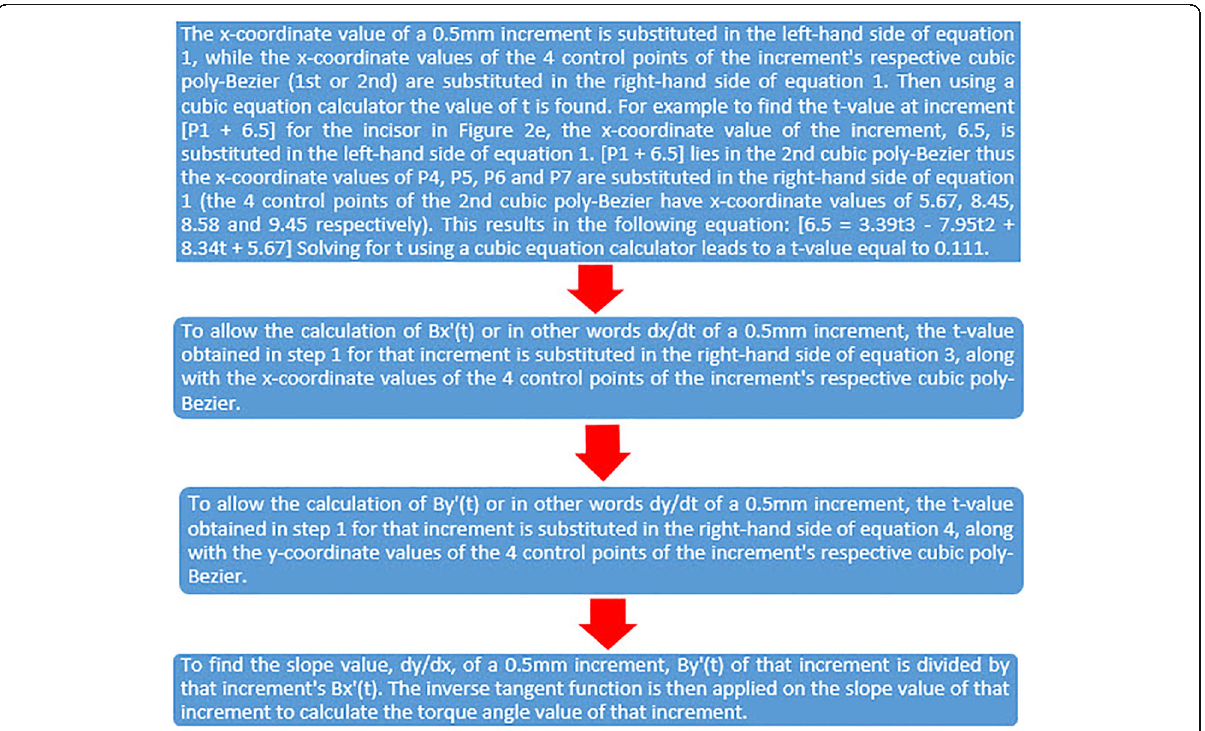
Fig. 4 The procedures done to calculate the torque angle value at any 0.5-mm increment are described here in four steps. All the equations mentioned here are found in Fig. 3 and a specially formed Excel spreadsheet containing all these equations in addition to cubic and quadratic equation calculators, allowed all the procedures listed here to be